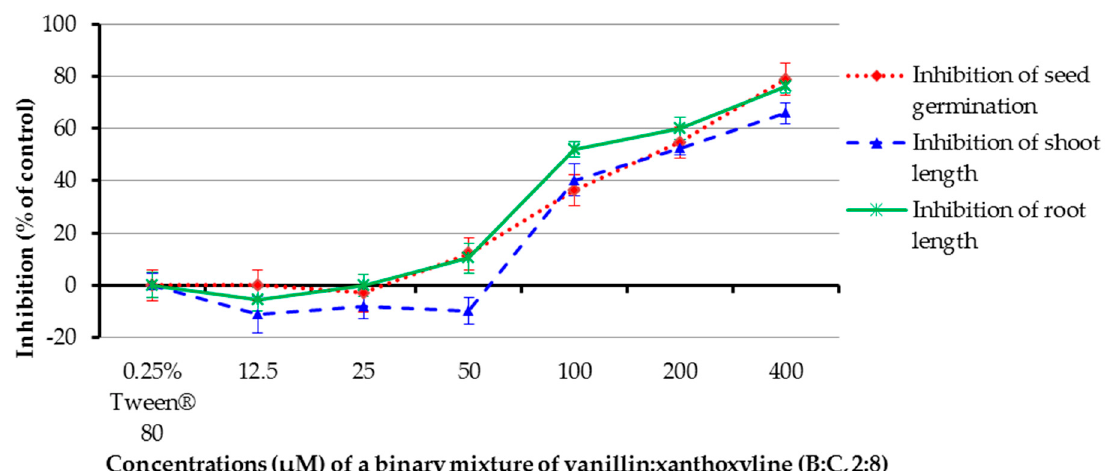
Figure 8. Inhibitory effects of a binary mixture of vanillin:xanthoxyline (2:8) on seed germination and shoot and root growth of Chinese amaranth. A 0.25% aqueous solution of Tween ® 80 was used as a control.